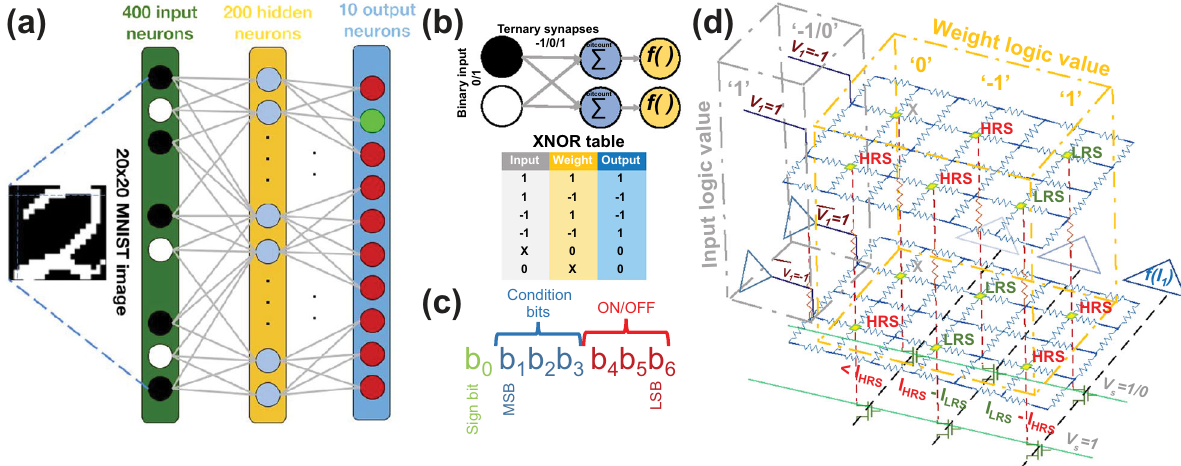
Fig. 6 The neural network structure for VRRAM arrays. a A 2-layer MLP neural network used in this work with binary (black/white) input signals. b Schematic and table of the XNOR operation with 1-bit ternary ( − 1/0/1) synapses. c Weight quantizing to a 1-bit ternary precision scheme, where the sign and three MSB (i.e., condition bits) determine the ternary level (Supplementary Table 3). d The proposed XNOR operation-focused architecture for 3D VRRAM